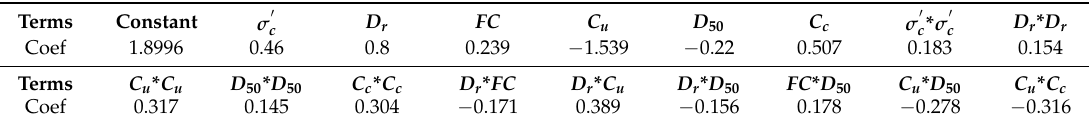
Table 10. RSM equation with the DOE of the HCC based on the second ANN model (R 2 = 94.63%, R 2 [adjust] =